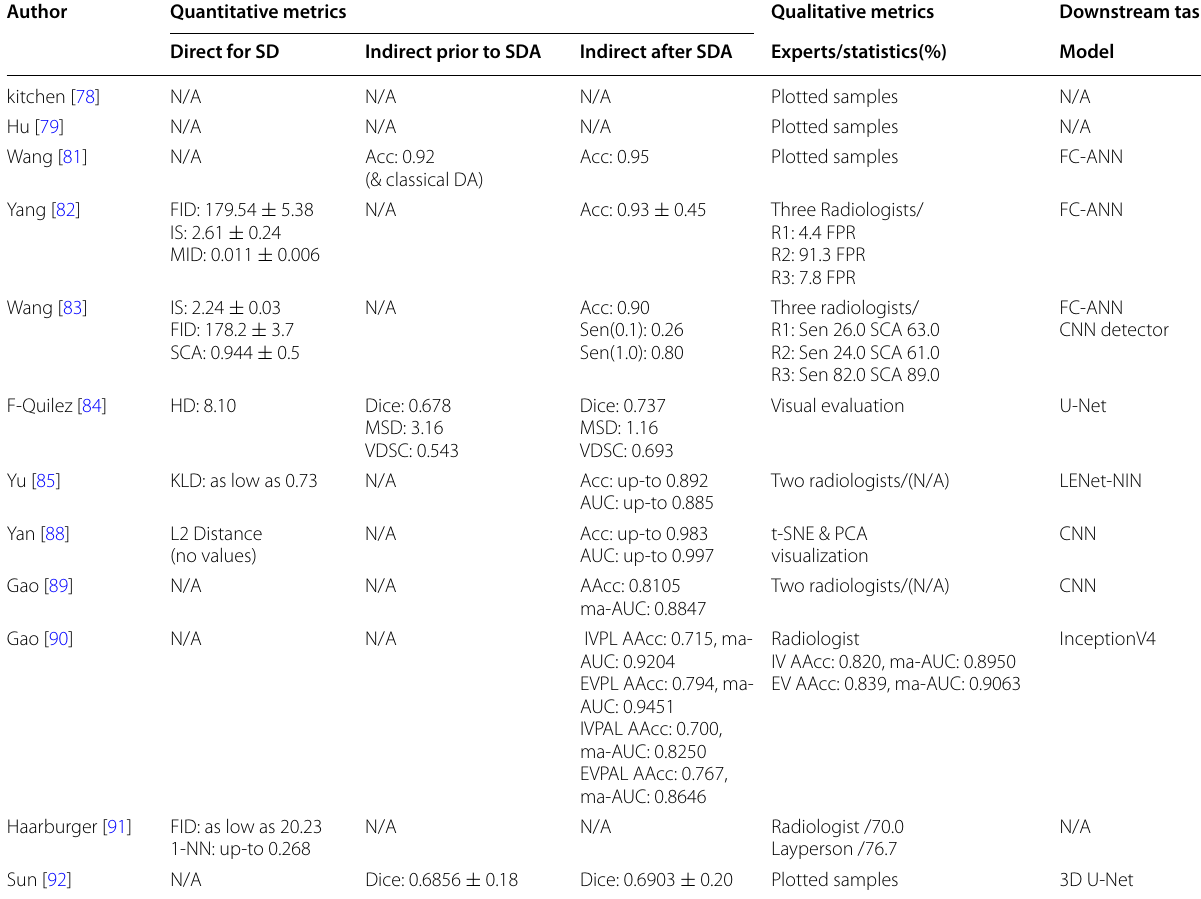
SD, Synthetic Data; SDA, Synthetic Data Augmentation; Acc, Accuracy; FID, Frechet Inception Distance; IS, Inception Score; MID, Mutual Information Distance; FPR, False Positive Ratio; SCA, Slice-level Classification Accuracy; Sen, Sensitivity; Spe, Specificity; HD, Hausdorff Distance; MSD, Mean Surface Distance; VDSC, mean Volumetric DSC; KLD, Kullback–Leibler Divergence; AUC, Area Under the Curve; t-SNE, t-distributed Stochastic Neighbor Embedding; PCA, Principal Component Analysis; IVPL, Internal Validation Patch Level; EVPL, External Validation Patch Level; IVPAL, Internal Validation PAtient Level; EVPAL, External Validation PAtient Level; AAcc, Average Accuracy; ma, micro-averaging; 1-NN, Nearest Neighbor; N/A, Not applicable; Symbol ’-’ represents that the corresponding information was not provided in the